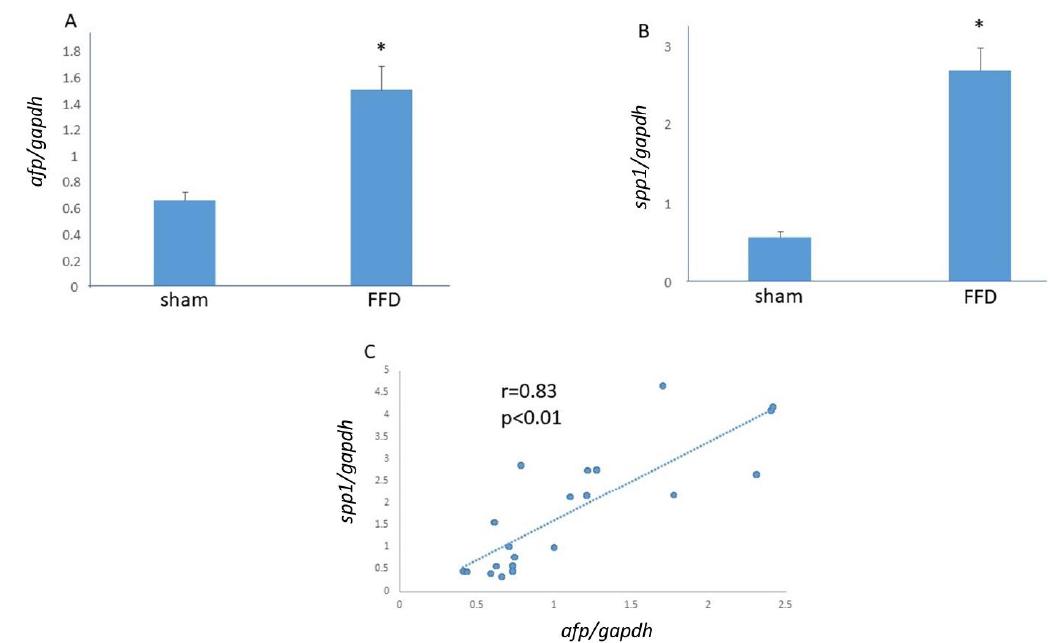
Figure 3. Hepatic oncogenes in NASH with fibrosis: ( A ) an increased expression of afp in the FFD cohort. ( B ) An increased expression of opn/spp1 in the FFD cohort. *, p < 0.01. ( C ) The correlation between hepatic afp and opn/ssp1 yielded an r = 0.83, p < 0.01.